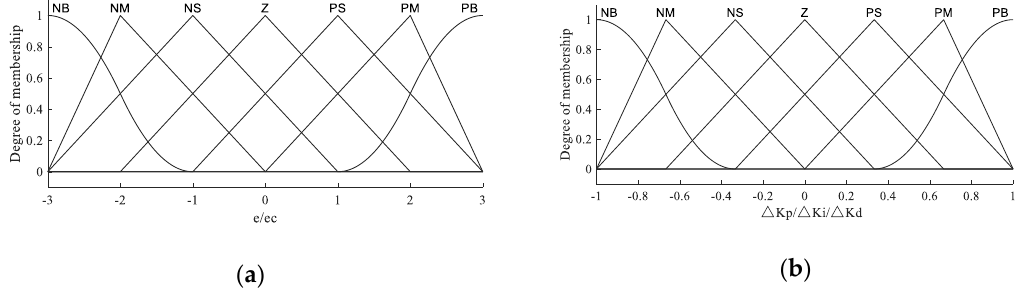
Figure 6. Input and output variable membership function: ( a ) Membership function of the